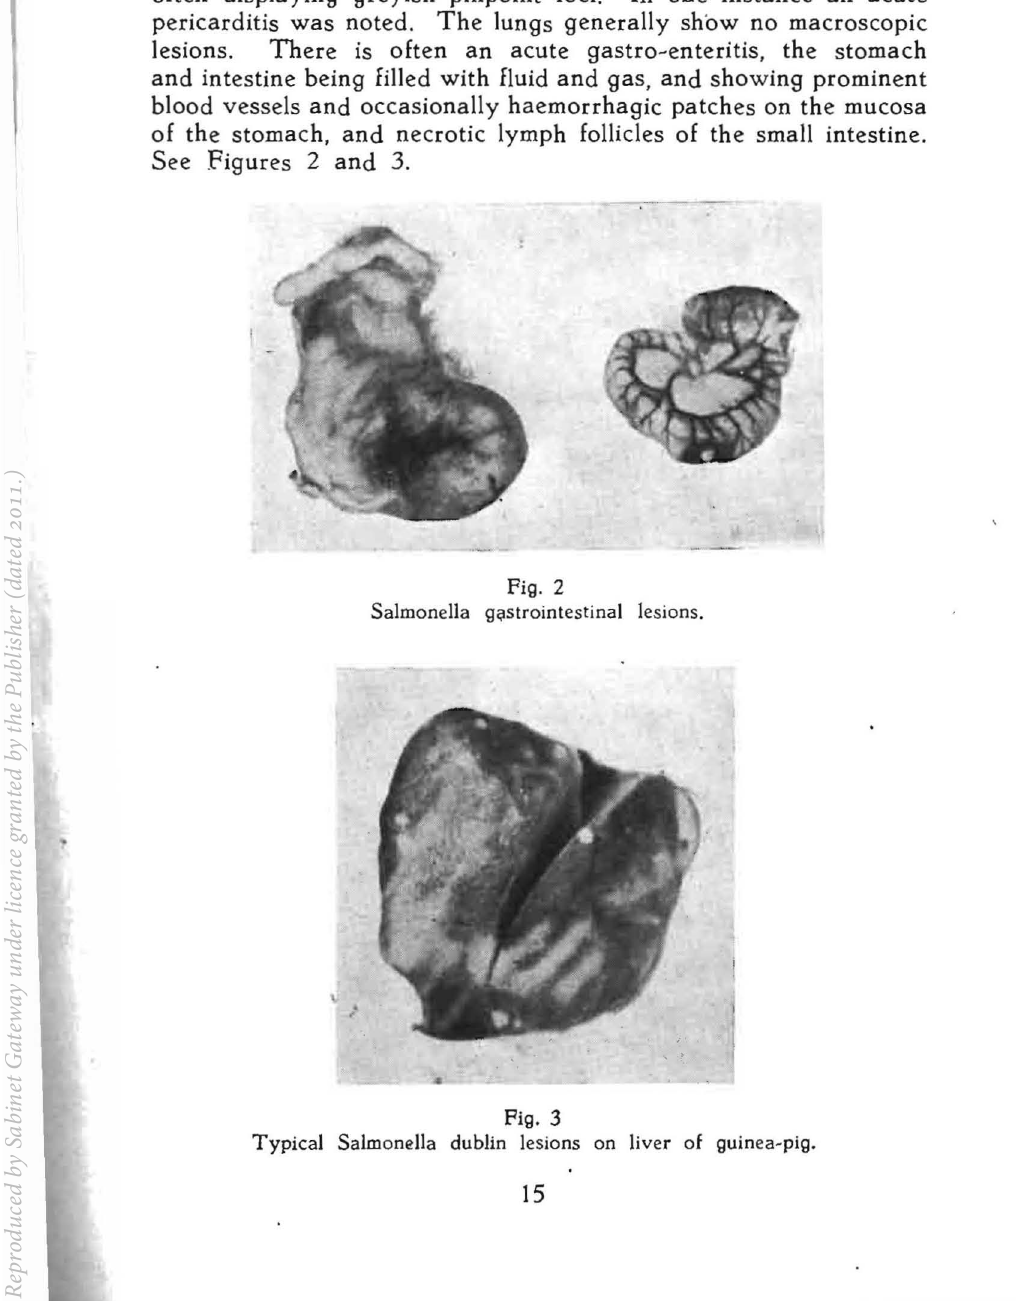
Fig. 2 Salmonella g<;lstrOintestinal lesions.